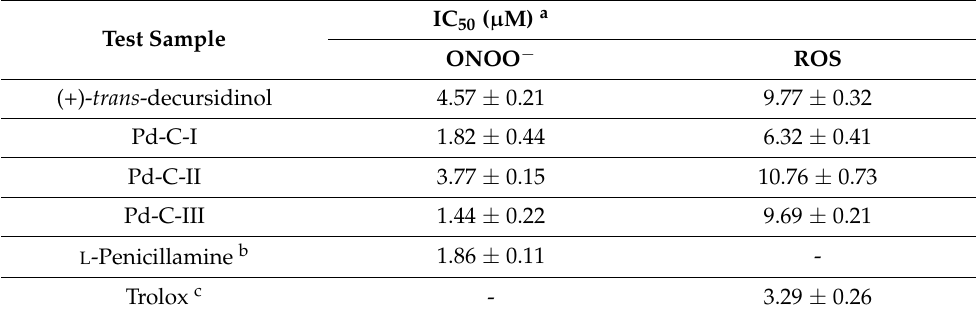
Table 4. Inhibitory effects of dihydroxanthyletin-type coumarins on ONOO − and ROS.